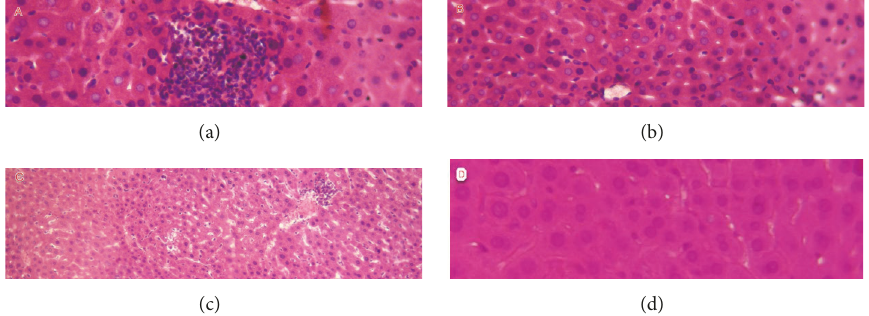
Figure 4: Histologic section of liver tissue of control and treated mice (section of parenchyma stained with H&E, x 40). (a), (b), and (c) are histologic sections of liver tissue of treated mice with 1.5 and 2 g/kg/day; (d) is a section of liver tissue of control